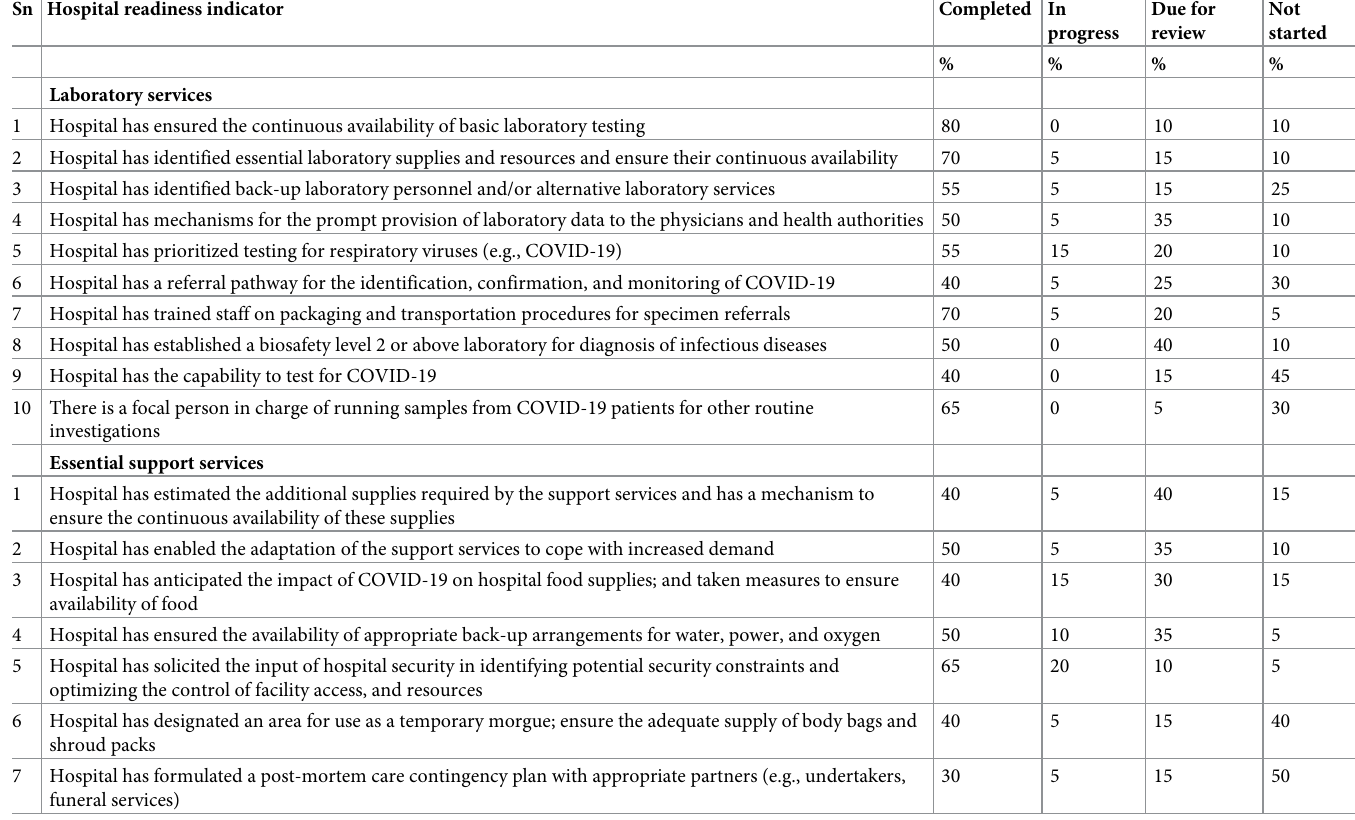
Table 10. Implementation of laboratory services and essential support services readiness indicators among 20 hospitals in Nigeria. Sn Hospital readiness